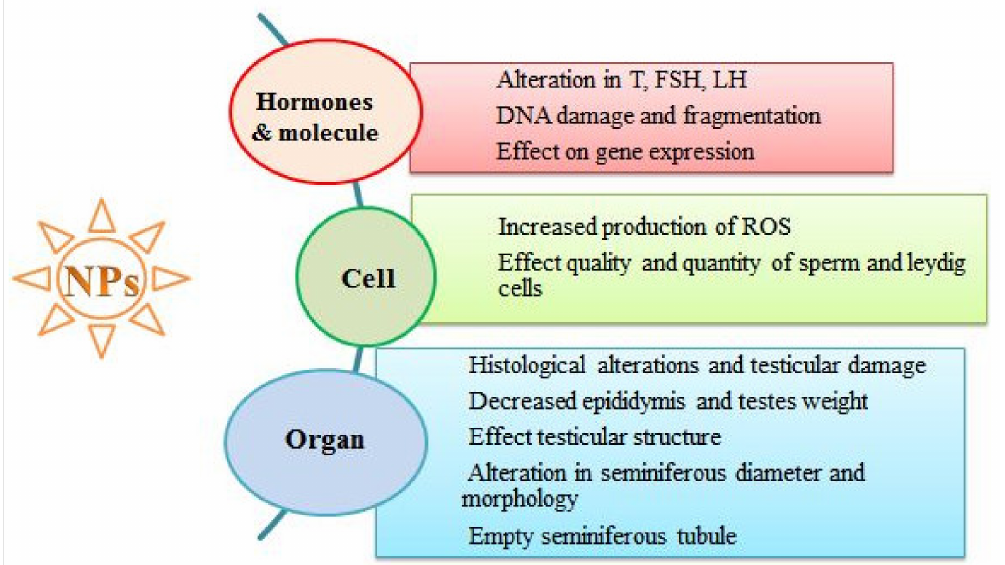
Figure 3. Exposure to NPs and their reproductive toxic effects at various biological